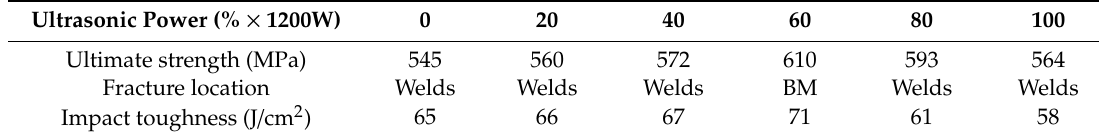
Table 2. Mechanical properties of joints.